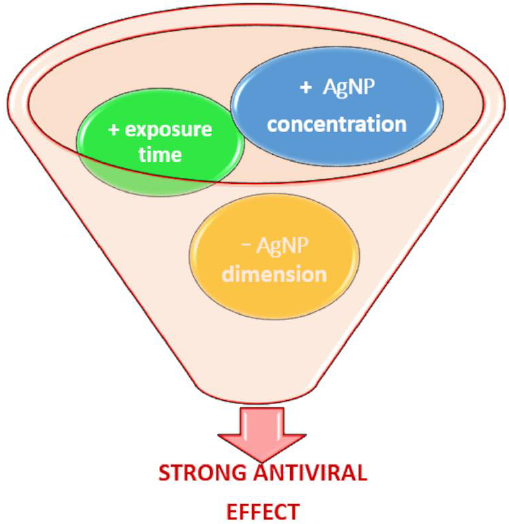
Figure 1. Scheme of the effect of dimension, concentration and exposure time on the antiviral effect of AgNPs. A strong antiviral effect is obtained if AgNPs in small dimensions are used in higher concentrations and exposed to viruses for longer times.